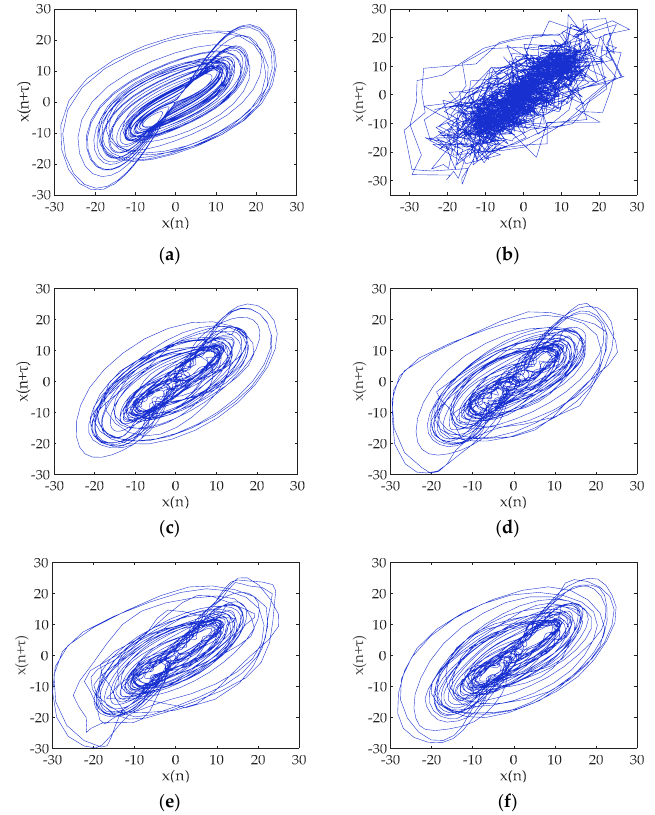
Figure 10. Phase diagrams for ( a ) the noiseless Chen’s signal; ( b ) the noisy Chen’s signal when SNR is 11 dB; ( c ) the EMD-DE-IT method; ( d ) the EEMD-DE-IT method; ( e ) the CEEMD-DE-IT method; and ( f ) the proposed method. ( f ) the proposed method.